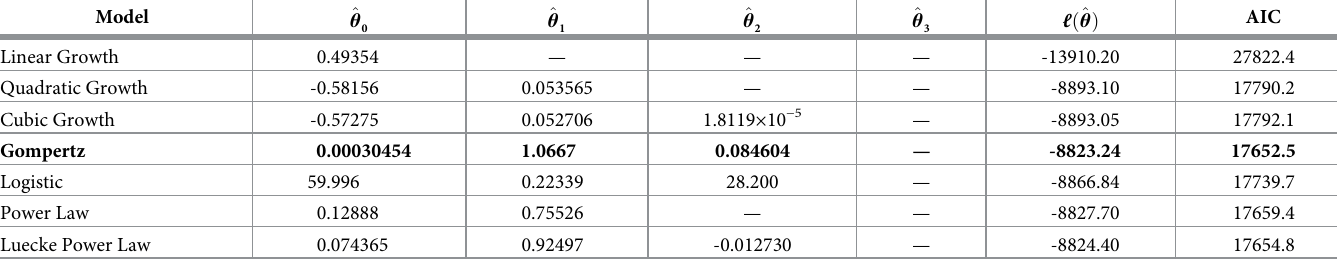
Table 21. Fetal lung mass models (g vs. fetal mass in g for power law models, g vs. gestational age in weeks for all other